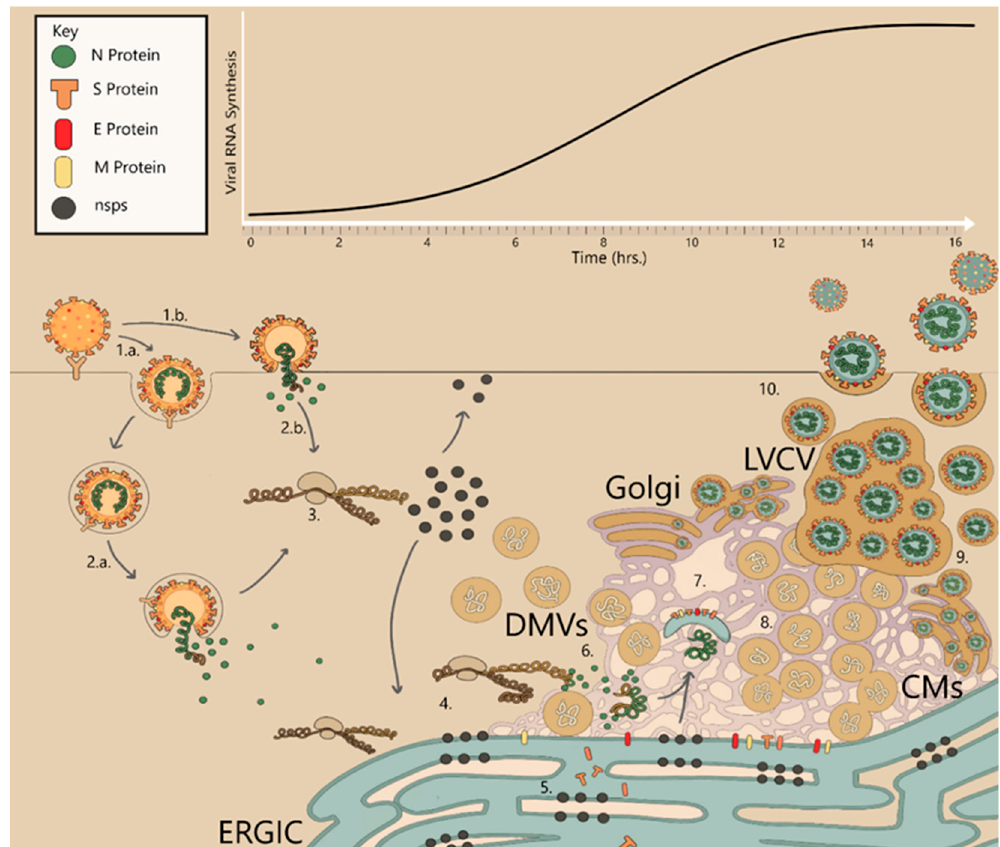
Figure 2. The infection cycle of coronaviruses. 1.a. Endocytic entry of virus particles after attaching to receptor proteins. 22222222222222 1.b. Immediate fusion at the surface of the cell upon attachment to receptor protein. 2.a. Endocytic fusion of viral and host membranes after endosomal maturation. 3. After shedding N protein from the genome, viral RNA is translated, expressing nsps from pp1a and pp1ab. Nsps migrate to the ER and perinuclear spaces, and RdRp complexes form to reverse transcribe additional viral transcripts and genomes. 4. Nsp3, nsp4 and nsp6 begin membrane rearrangements and form CMs and DMVs. 5. Viral structural proteins are produced and post-translationally modified in the ER/Golgi. 6. Viral genomes are encapsulated by N proteins. 7. Encapsulated genomes are wrapped by lipid envelopes assembled by structural proteins S, M and E. 8. Late-stage membrane rearrangements, many interconnected DMVs spread through perinuclear space with dsRNA within them. The Golgi has many virions budding from it with LVCVs attached to its membranes. 9. Mature CoV virions bud from ERGIC. 10. Exit of progeny CoV viruses via lysosomal